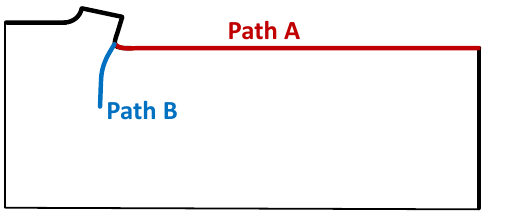
Figure 6. Schematic of Paths A and B on the model, where the temperature was analysed. The values of the temperatures on both paths for evaluating the effect of the cutting speed on the model with a constant sample density (40 PCF) are shown in the graph in Figure 7a. On Path A, the temperature range for the cutting speed of 133 mm/s was in the range 121.8–35.0 ◦ C, that for the speed of 500 mm/s was in the range 129.8–34.3 ◦ C, and that for the speed of 833 mm/s was in the range 171.5–25.5 ◦ C. On Path B, the temperature for the cutting speed of 133 mm/s was in the range 121.8–20.3 ◦ C, that for the speed of 500 mm/s was in the range 129.8–20.0 ◦ C, and that for the speed of 833 mm/s was in the range 171.5–9.2 ◦ C. The temperatures on both paths for evaluating the effect of density on the model with a constant cutting speed (500 mm/s) are shown in Figure 7b. On Path A, the temperature for the 10 PCF sample was in the range 81.4–26.9 ◦ C, that for the 25 PCF sample was in the range 109.4–30.1 ◦ C, and that for the 40 PCF sample was in the range 129.8–34.3 ◦ C. On Path B, the temperature for the 10 PCF sample was in the range 81.4–20.4 ◦ C, that for the 25 PCF sample was in the range 109.4–21.0 ◦ C, and that for the 40 PCF sample was in the range 129.8–20.0 ◦ C.